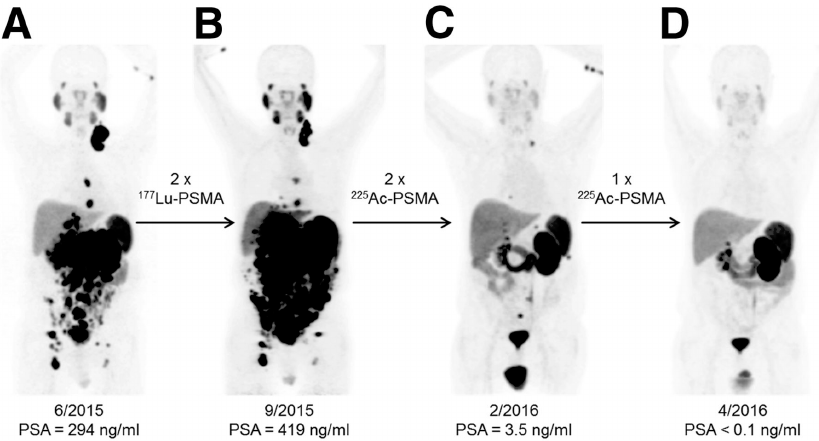
Figure 3. An example of the effective response of a prostate cancer patient to 225 Ac-PSMA-617 treatment. This research was originally published in the Journal of Nuclear Medicine [127]. Kratochwil C, Bruchertseifer F, Giesel FL, Weis M, Verburg FA, Mottaghy F, Kopka K, Apostolidis C, Haberkorn U, and Morgenstern A. 225Ac-PSMA-617 for PSMA-Targeted α -Radiation Therapy of Metastatic Castration-Resistant Prostate Cancer. J Nucl Med. 2016;57(12):1941-1944. © SNMMI. 68 Ga-PSMA-11 PET/CT scans of patient B in this manuscript (a prostate cancer patient who presented with peritoneal carcinomatosis and liver metastases that were progressive under 177 Lu-PSMA-617 therapy). In comparison to the initial tumor spread ( A ), restaging after 2 cycles of β -emitting 177 Lu-PSMA-617 presented progression ( B ). In contrast, restaging after second ( C ) and third ( D ) cycles of α -emitting 225 Ac-PSMA-617 presented an impressive response. Adapted from ref.